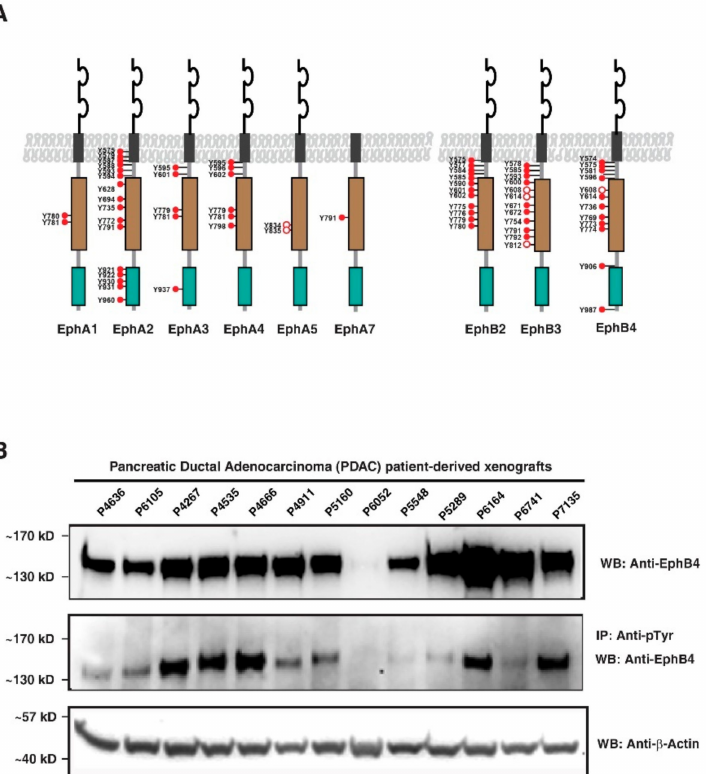
Figure 4. Highly activated ephrin receptors: ( A ) As indicated in red dots, most of the ephrin receptor tyrosine kinases were found to be tyrosine phosphorylated with EphA2 and EphB4 being most hyperphosphorylated; ( B ) Western blot showing total EphB4 expression (top panel), phosphorylated EphB4 (middle panel) and actin as a loading control (bottom panel) in PDX samples. Full pictures of the Western blots are shown in Supplementary